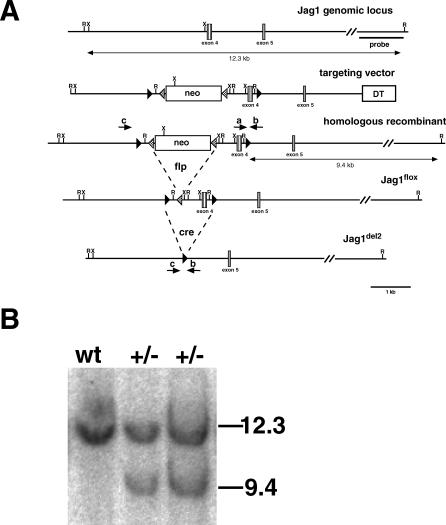
Construction of a Conditional Allele of the Jag1 Gene(A) Schematic diagram showing the strategy for generating Jag1flox mice. The targeting vector was designed to insert loxP sites (black arrowheads) on either side of exon 4, the DSL domain-encoding exon (white area in exon 4). The neomycin resistance cassette (for positive selection) was flanked by FRT sites (gray arrowheads) so that it could later be removed by crossing to FLPe-expressing mice. A diphtheria toxin gene was included for negative selection. Dotted lines depict the recombination events that occur when either the FLPe or Cre recombinases are present. Primer positions for genotyping are shown as small black arrows (a, DSLF; b, J1LoxR1; c, J1FlpF1; see Materials and Methods for sequences). DT, diphtheria toxin; R, EcoR1; X, Xba1.(B) Southern blot analysis of EcoRI-digested DNA from ES cells using the external probe shown in (A). Left lane shows the wild-type band (12.3 kb), and the center and right lanes show correctly targeted ES cells that have both a wild-type band and a smaller mutant band (9.4 kb).